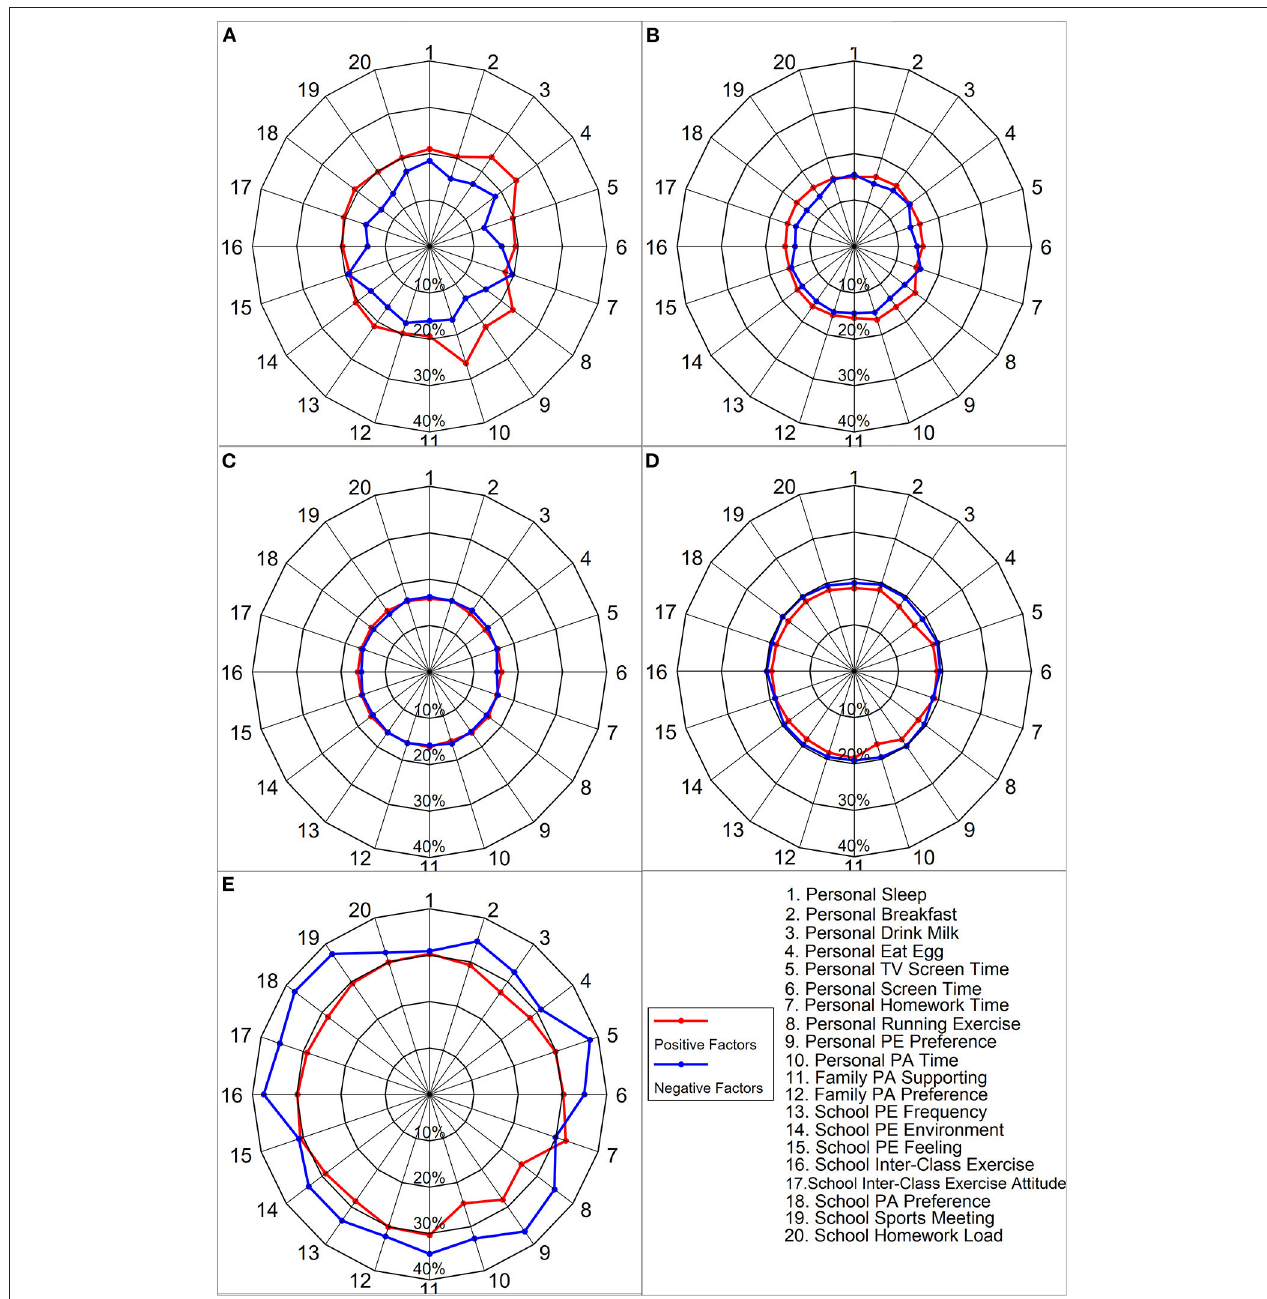
FIGURE 1 | Differences in the five levels of physical fitness between positive and negative responses of 20 questions in questionnaire surveys. (A) High levels PFI. (B) High-middle levels PFI. (C) Middle levels PFI. (D) Low-middle levels PFI. (E) Low levels PFI. The number at the outer edge of the radar map represents the specific factors in the last legend subfigure. The number of percentages in the radar map represents the reference number of each line. For example, 40% represents the percentage of selected positive or negative responses of each question option (red line vs. blue line) outer line of the radar map. The statistically significant percentage difference between the positive and negative responses groups is presented in Supplementary Table 2